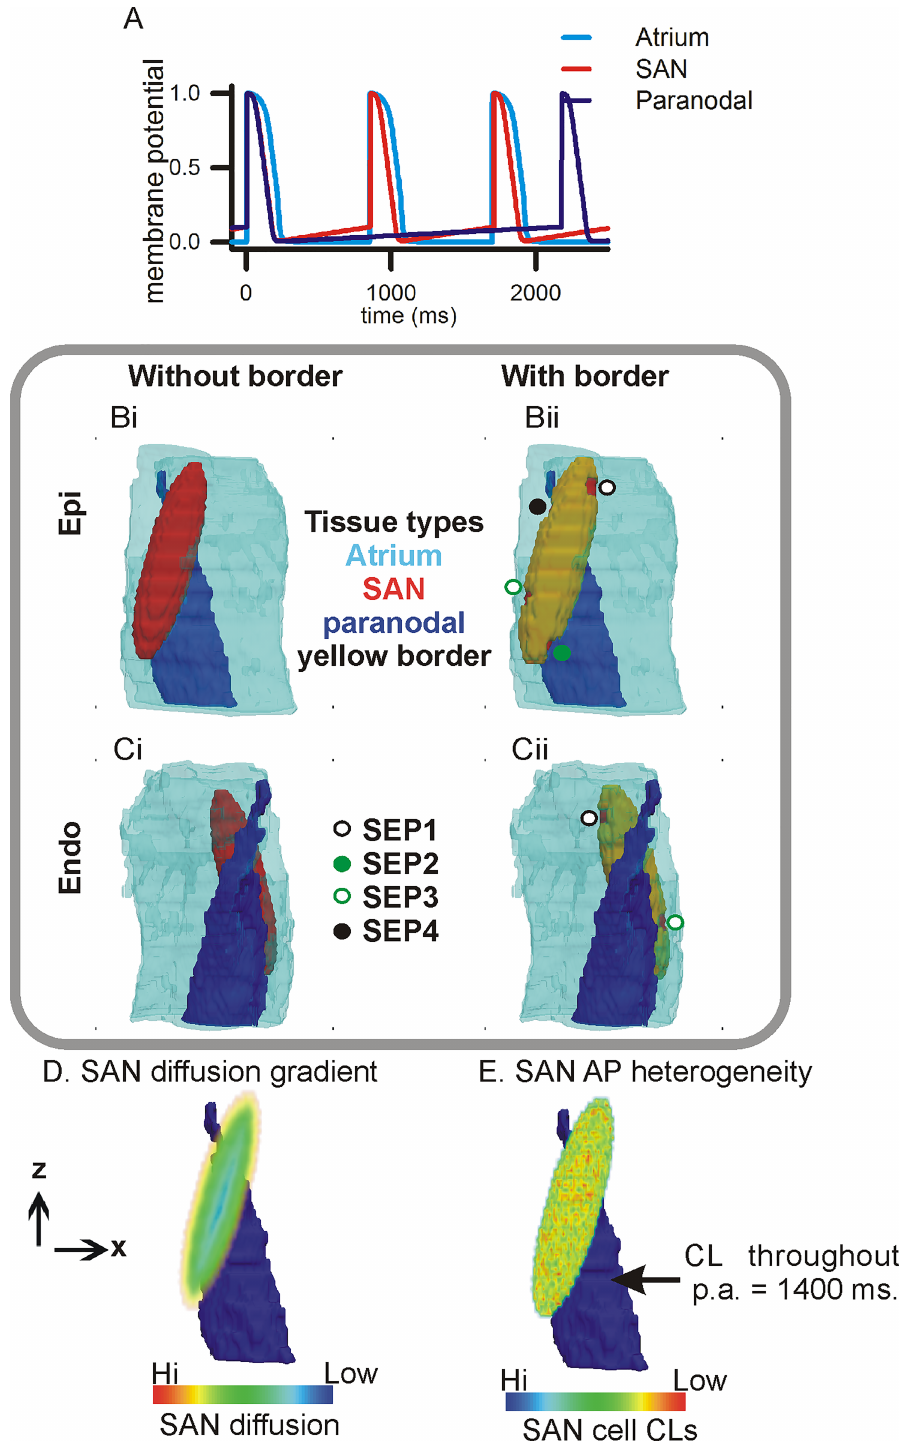
Fig 1. 3D electro-anatomical human SAN model. A: Action potentialprofiles of atrial (cyan), SAN (red), and paranodalarea (blue) cells. Gray box: Epicardial(Bi and Bii) and endocardial(Ci and Cii) views of the 3D anatomy consisting of atrial tissue (cyan), SAN (red), paranodalarea (blue), insulatingborder (yellowtissue encasingof the SAN in Bii and Cii), and SEPs. Left panels (Bi, Ci) show the anatomywithout border-SEPs. Right column (Bii, Cii) shows the anatomywith the insulating border-SEPs. D: Cell-cellcouplingcentre